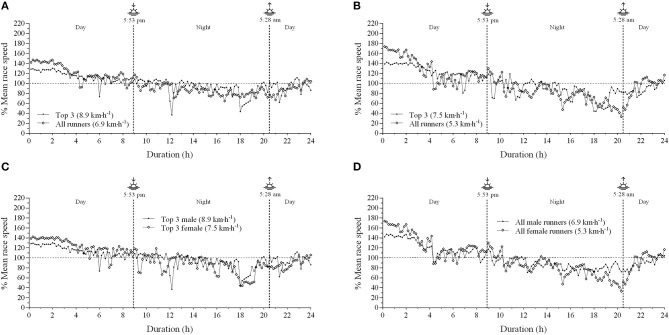
Relative mean race speed during the 24-h ultramarathon. (A) top 3 male and all male runners; (B) top 3 female and all female runners; (C) top 3 male and top 3 female runners (D) all male and all female runners; Top 3, the overall 3 best runners. Mean speed was reported in brackets.